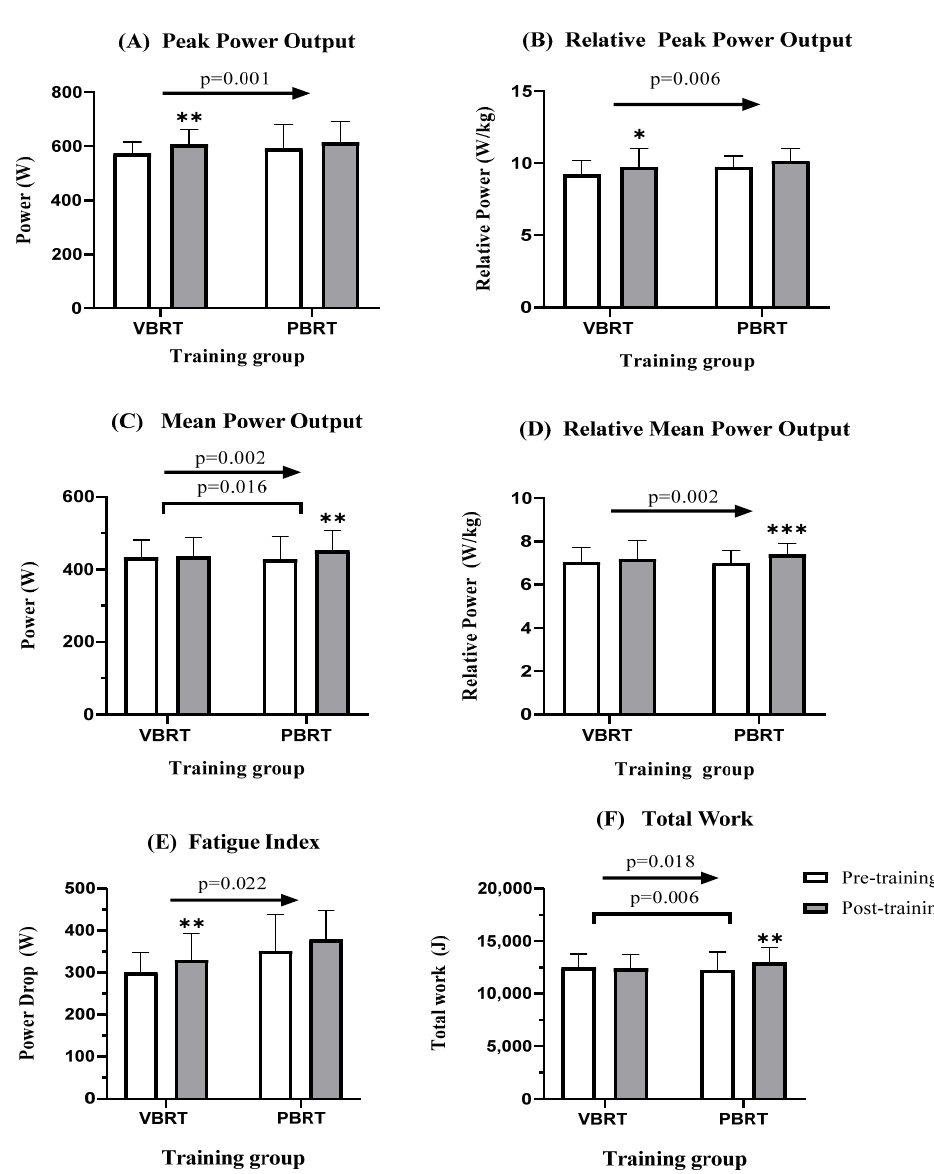
Figure 2. Mean changes in absolute ( A ) and relative peak power output ( B ), absolute ( C ) and relative mean power output ( D ), fatigue index ( E ) and total work ( F ) for the Wingate anaerobic power test after 6 weeks of training. * indicates significant difference baseline vs post-intervention: * p < 0.05, ** p < 0.01, *** p < 0.001; → indicates significant time effect; p -value show significant group by time effect.